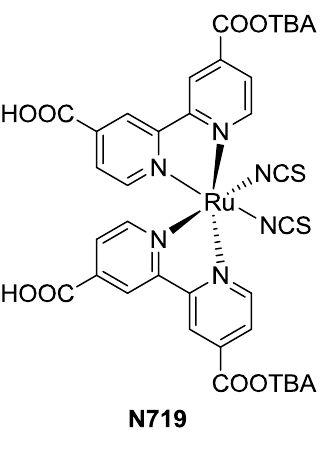
Figure 3. N719 structure.